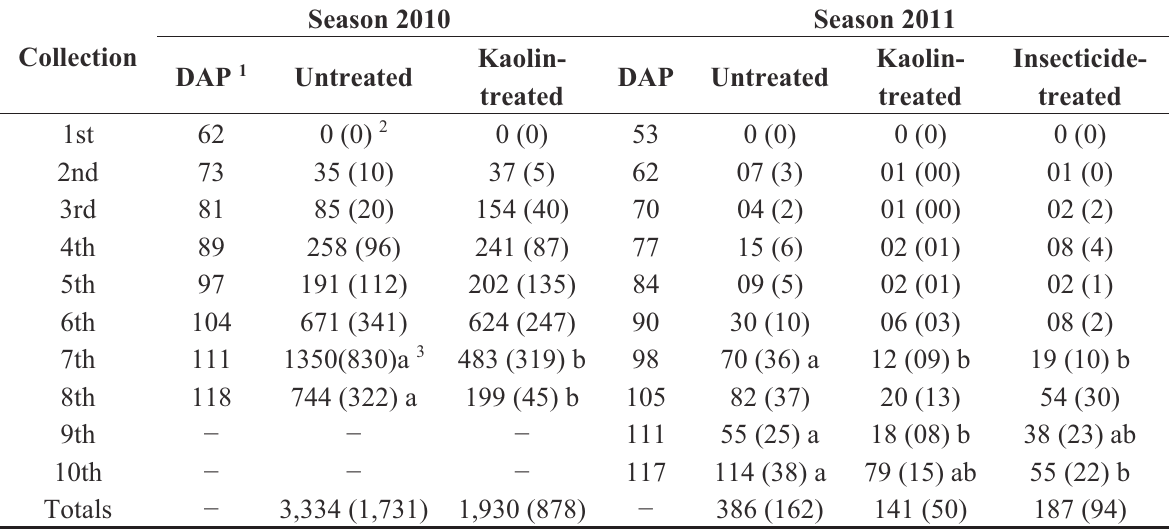
Table 2. Mean number of fallen damaged squares and bolls (emerged adult weevils) collected during the 2010 and 2011 cotton-growing seasons in the study plots on family farms in the Semiárido region of